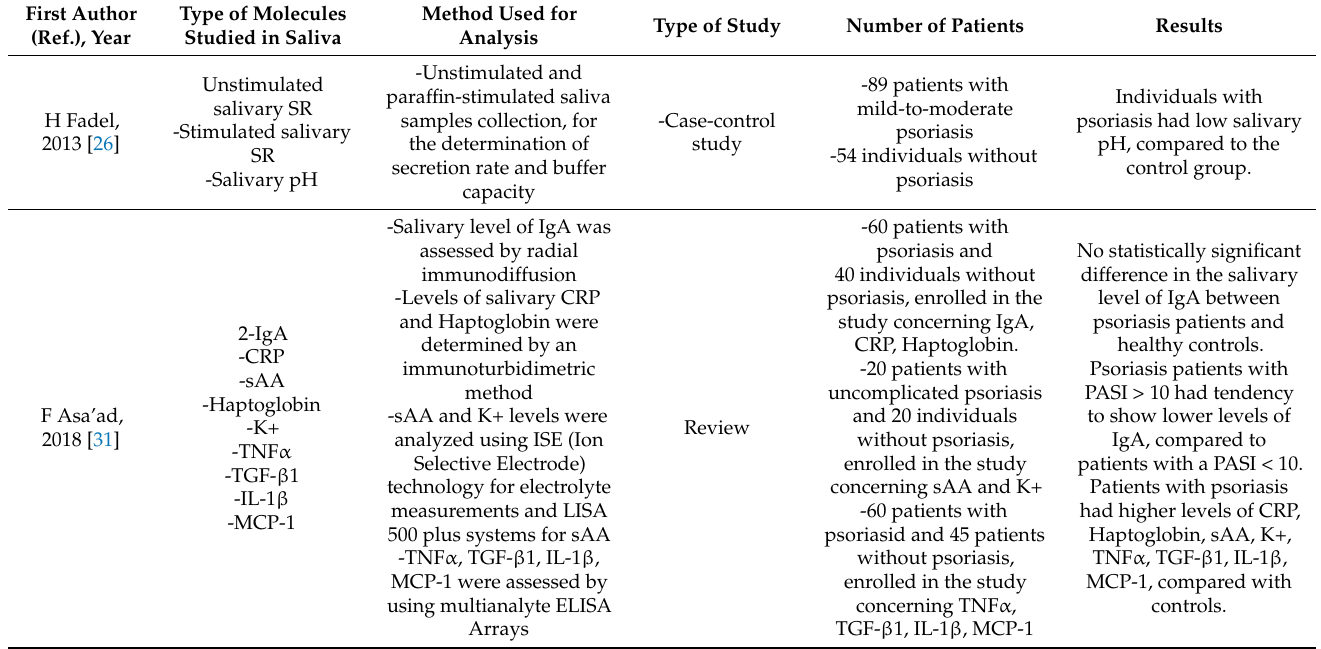
Table 1. Summary of the studies performed on the saliva of patients with